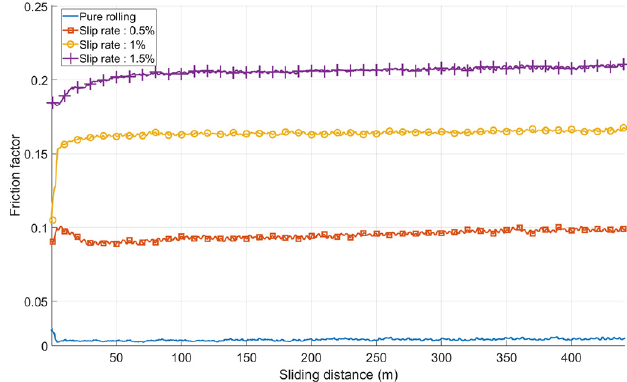
Fig. 10. Repeatability of a series of tests performed with leaves under a slip rate of 1 % and a RH of 50 % , average: 0.17, and maximum standard deviation: 0.031.